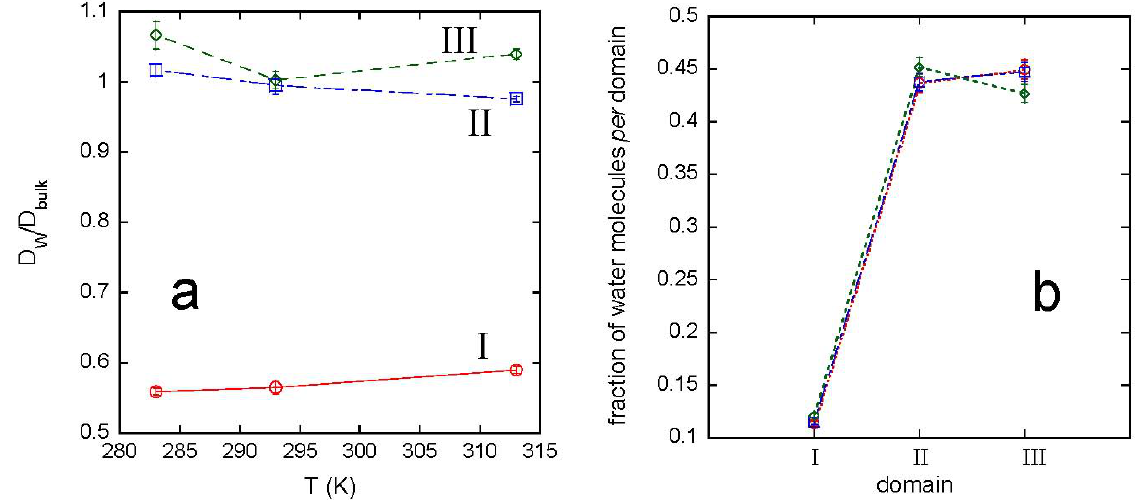
Figure 7. (a) Ratio between the water diffusion coefficient in I, II and III domains and the diffusion coefficient of bulk water. (b) Fraction of water molecules in I, II and III domains at 283, 293 and 313 K (red, blue and green symbols, respectively).